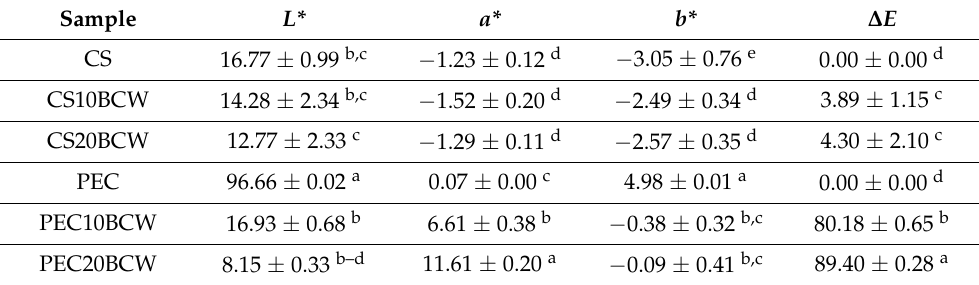
Table 3. Color parameters ( L* , a* and b* and the total color difference ∆ E ) of the tested film formulations. Sample